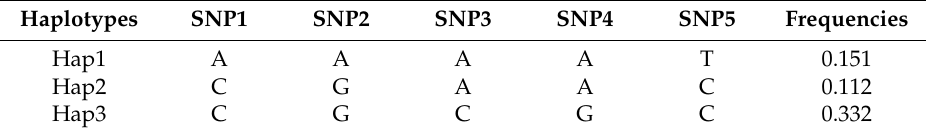
Table 4. Haplotypes and their frequencies in Qinchuan cattle (frequency >0.05 are shown).